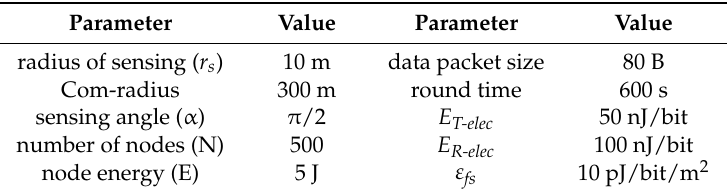
Table 1. Parameters of the environment for the